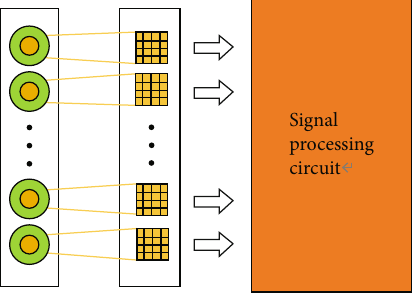
Figure 5: Size of the single-photon